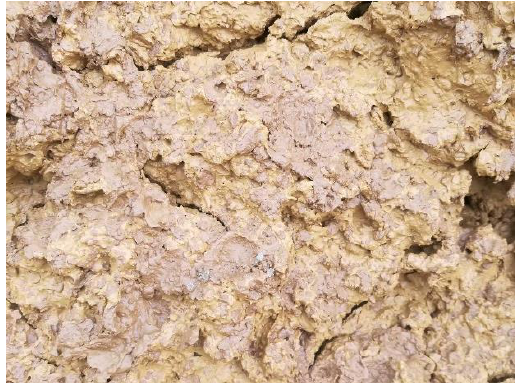
Figure 16. The borrowed soil.